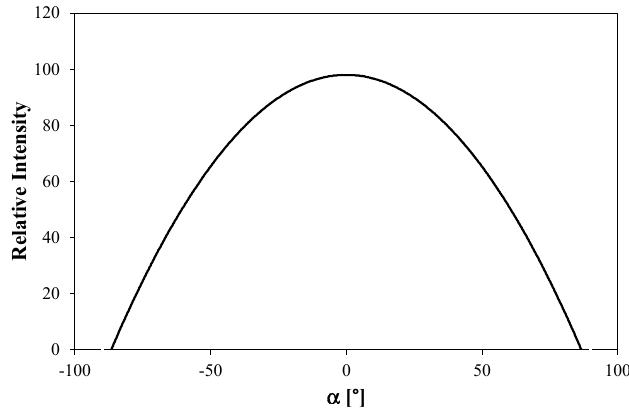
Figure 3. The catalog emission characteristic of the considered power LEDs.